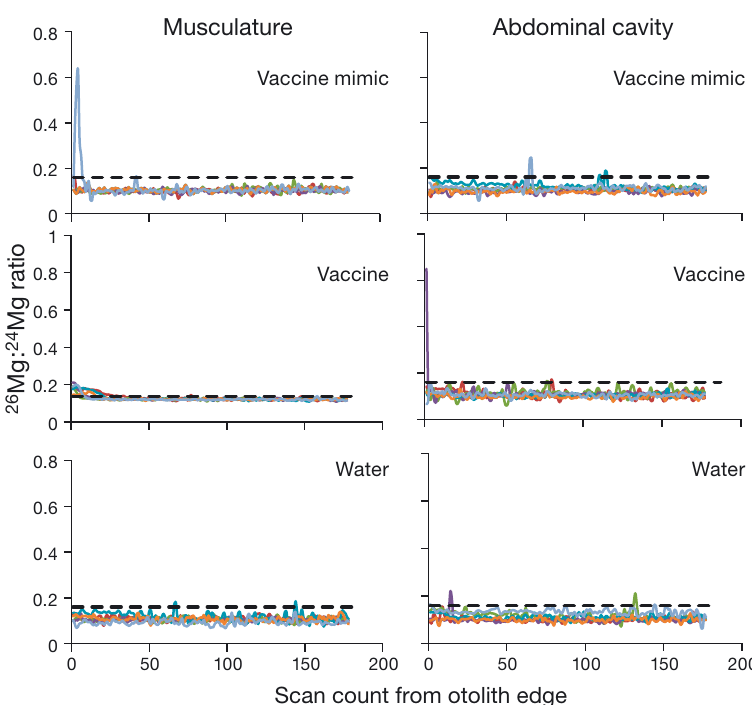
Fig. 3. Salmo salar. Mark success with 26 Mg: 24 Mg for the 6 enrichment treat- ments. Details as in Fig.